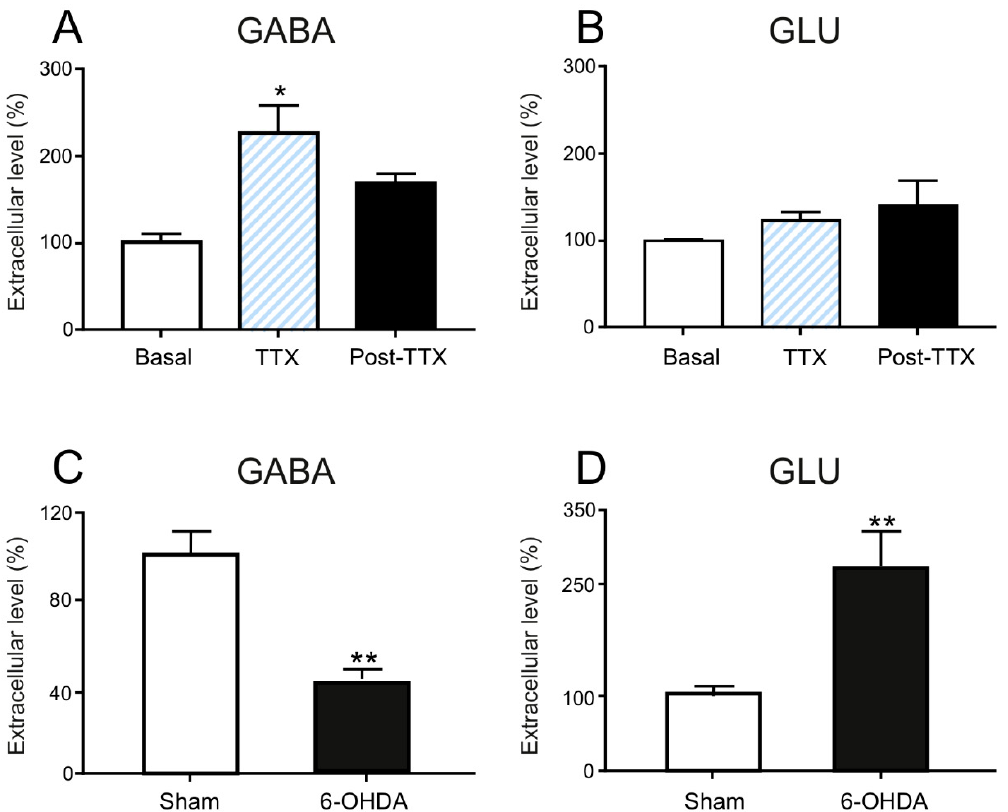
Figure 3. E ff ect of acute (TTX) and chronic (6-OHDA) dopamine (DA)-depletion on the extracellular levels of endogenous GABA and glutamate (GLU) in the motor thalamus (MTh). TTX infused in the medial forebrain bundle induced an increase in the endogenous GABA extracellular levels ( A ) while did not change the GLU levels in the MTh. Data in ( A ) and ( B ) are expressed as mean ± SEM normalized to the baseline levels (pre TTX infusion) from n = 14 experiments per group; * p < 0.05. One-and two-way ANOVA for repeated measures, followed by Dunnet’s multiple comparison test. 6-OHDA-lesion infused in the medial forebrain bundle produced, after 2 weeks, a decrease in GABA ( C ) and an increase in GLU extracellular levels in the MTh ( D ). Data in ( C ) and ( D ) are expressed as means ± SEMs normalized to sham-lesioned ( n = 9) neurotransmitter levels from n = 9 experiments per group; ** p < 0.01, unpaired student t -test.